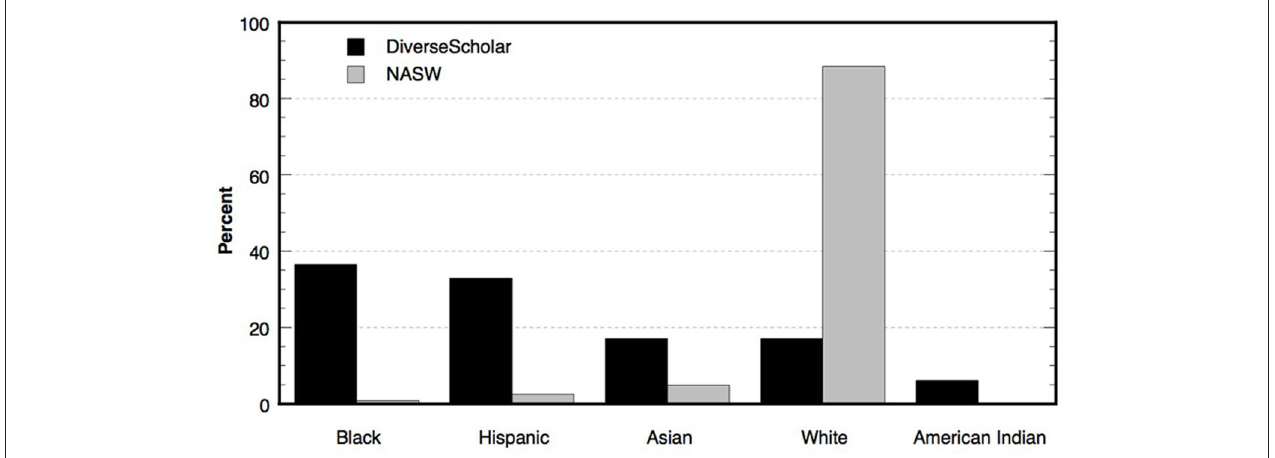
FIGURE 2 | Comparison of the ethnic/racial diversity of the DiverseScholar fellowship applicant pool (black) vs. the NASW membership (gray). The fractional percentage of the 82 fellowship applicants is compared to the ∼ 1,100 NASW membership survey respondents for the indicated ethnic/racial groups. Note that the depicted NASW “Asian” category combines the reported statistics for both Asians and South Asians since the DiverseScholar travel fellowship application combined these two